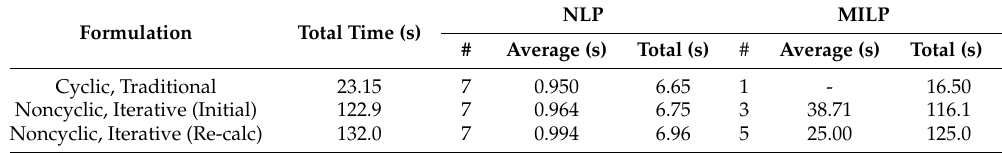
Table 26. Computational results: Scenario